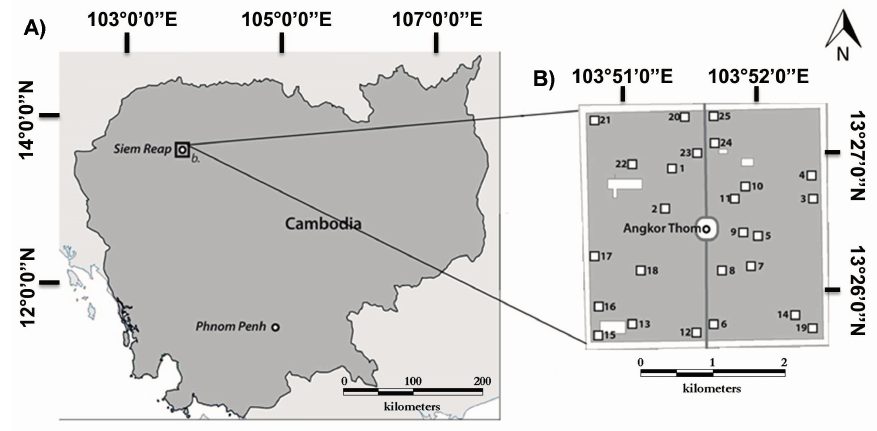
Figure 1. ( A ) Regional setting; and ( B ) Angkor Thom and the location of the 25, 1-ha above-ground biomass (AGB) field